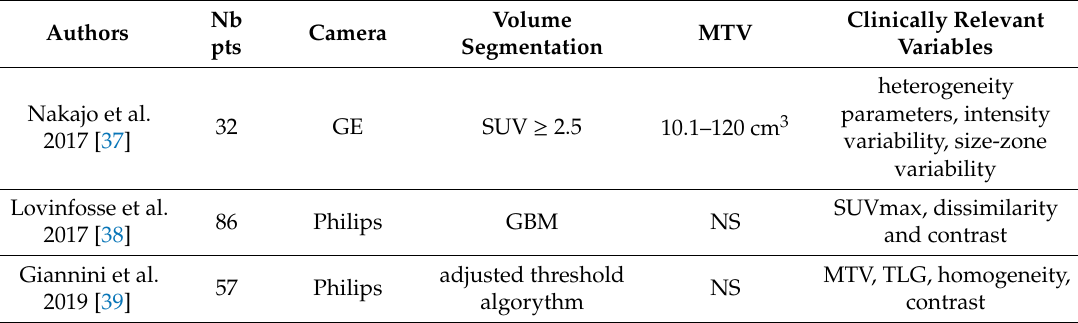
Table 2. Studies investigating texture analysis in colorectal carcinoma